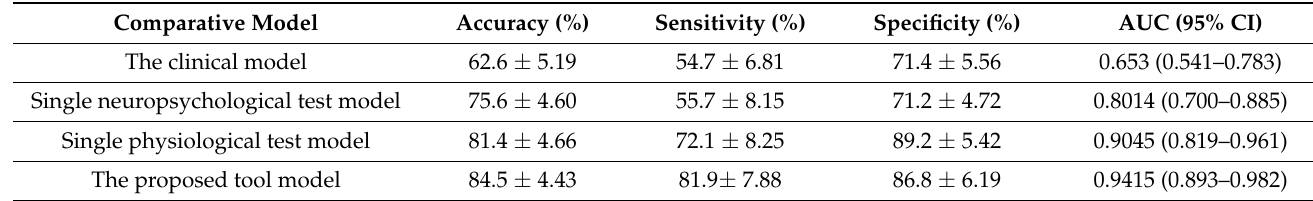
Table 3. The classification results of four models in cohort